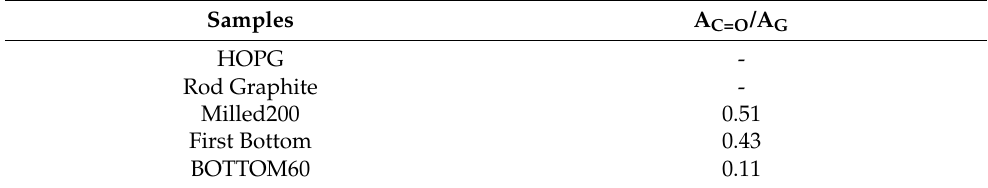
Table 3. Ratio between the IR C=O stretching band intensity and the IR G-band intensity for different samples at different steps of the GNPs preparation. Intensity is measured as an integrated